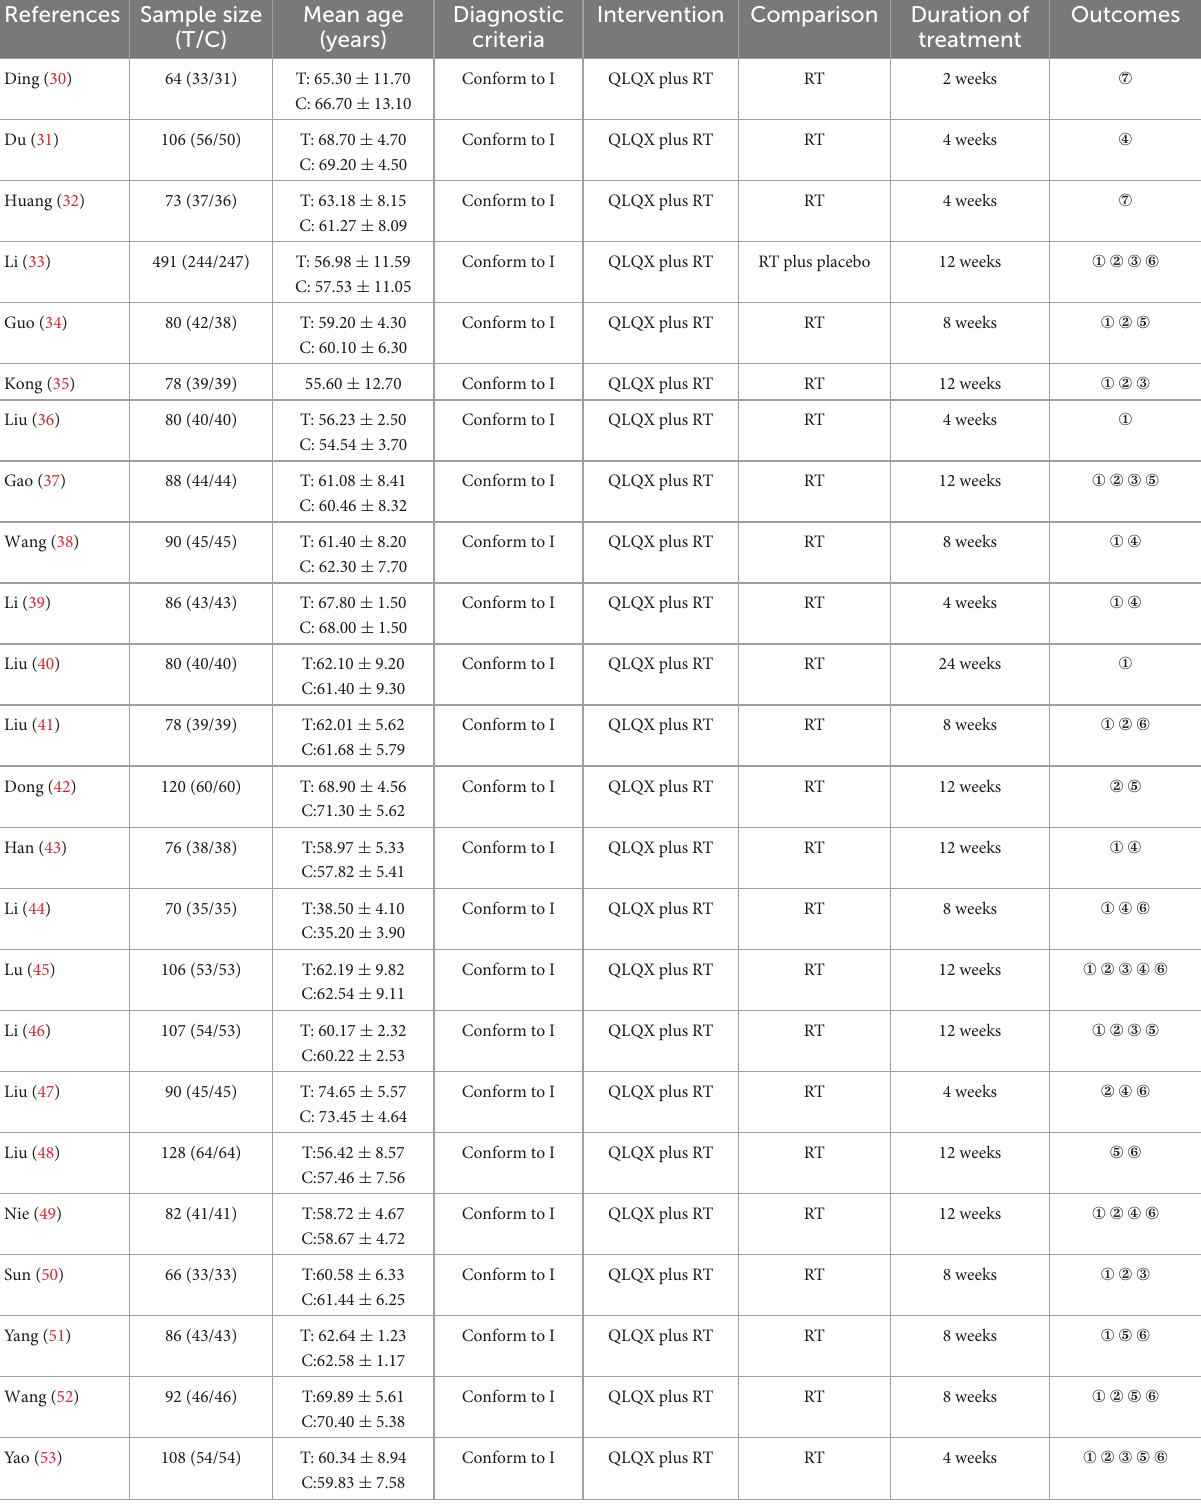
TABLE 2 Basic information of the included randomized controlled